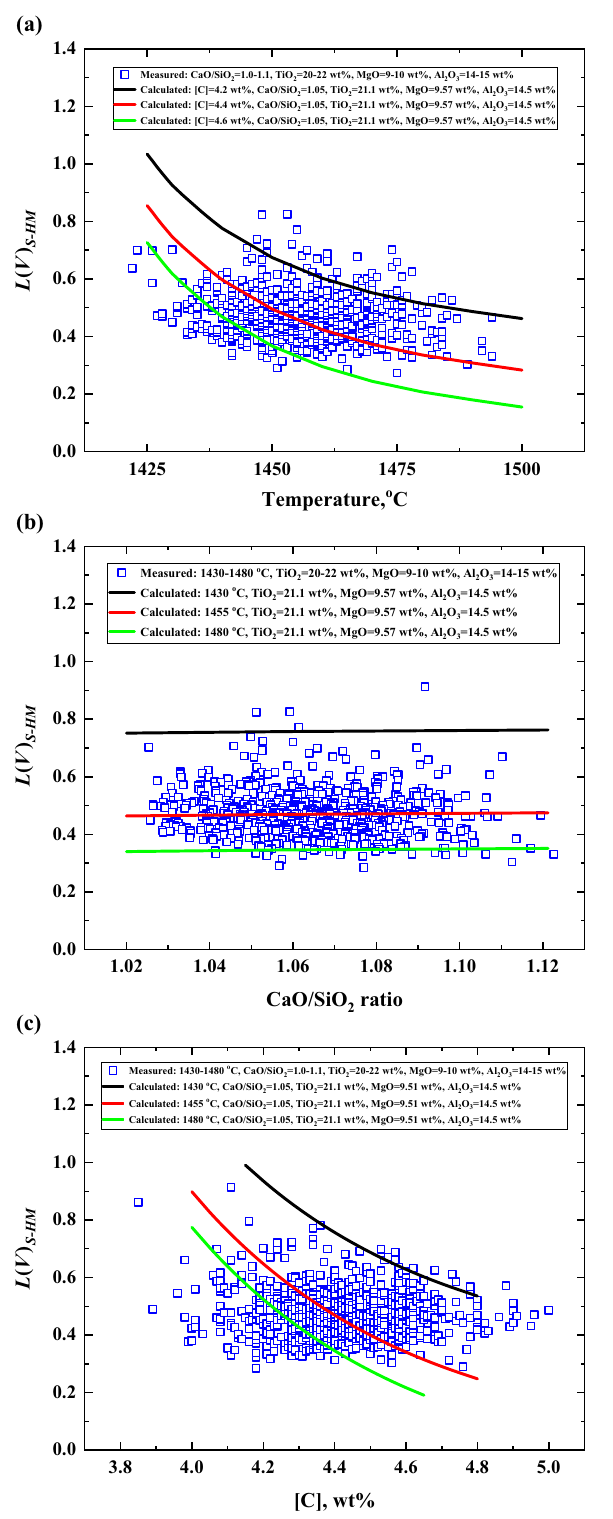
Figure 5: Variation of V distribution ratio between slag and hot metal ( ) - L V S HM as a function of ( a ) temperature, ( b ) CaO/SiO 2 ratio, and ( c ) C content in hot